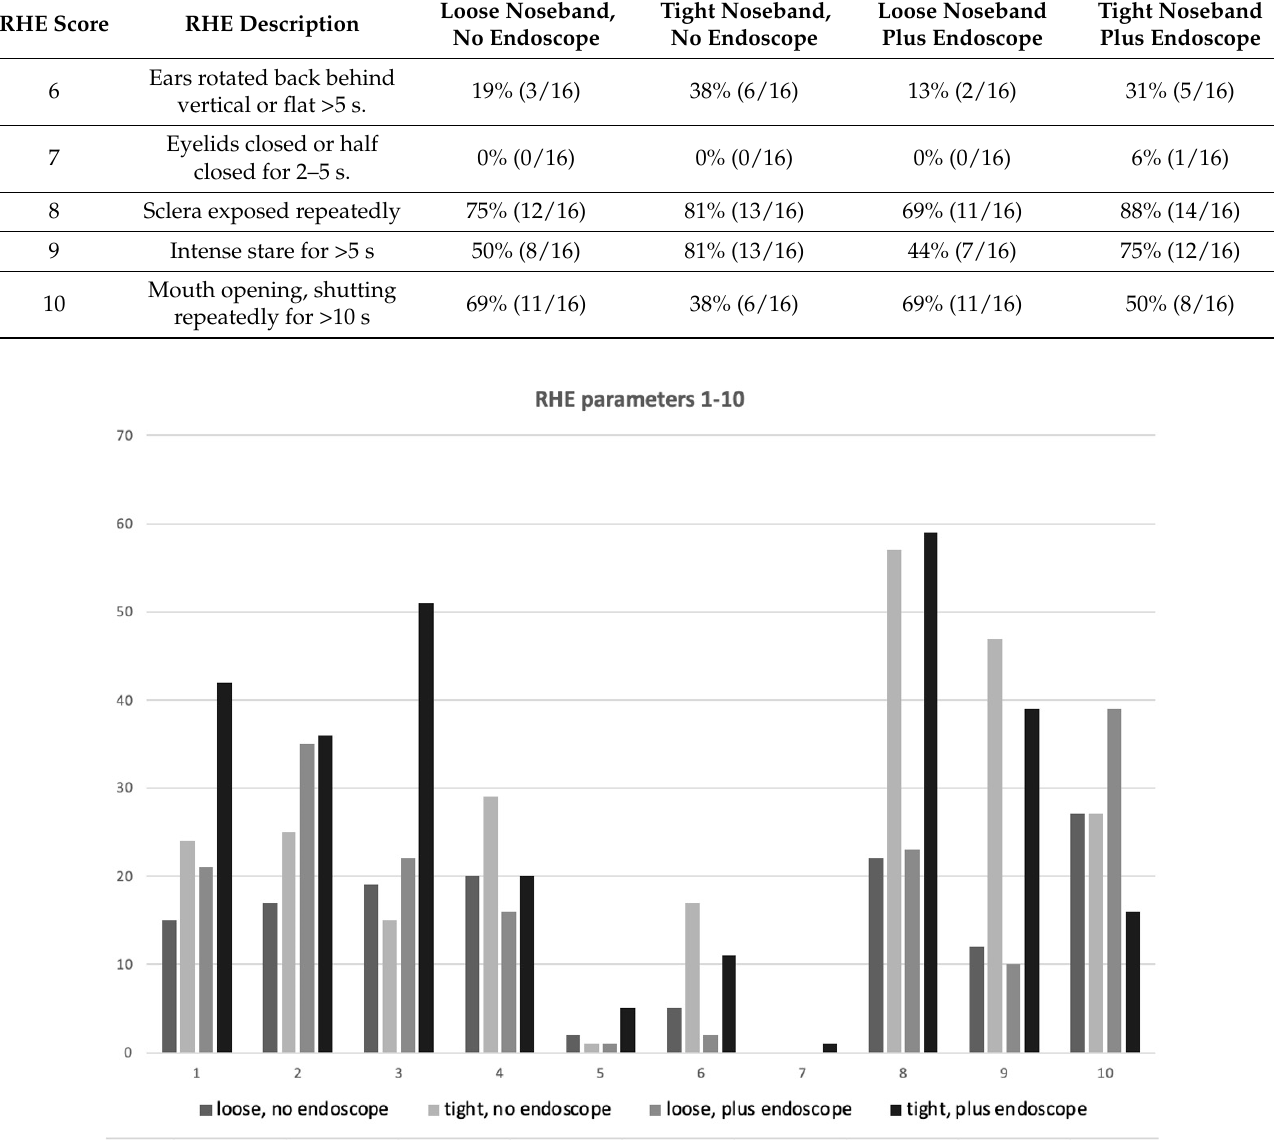
Figure 5. Frequency of individual RHE parameters 1–10 shown by the horses of each group (n = 16). The RHE scores correlated neither with the cortisol concentrations (level 1: p = 0.967, level 2: p = 0.419, level 3: p = 0.990, level 4: p = 0.268), nor with the SP levels (level 1: p = 0.929, level 2: p = 0.353, level 3: p = 0.456, level 4: p = 0.625). p = 0.929, level 2: p = 0.353, level 3: p = 0.456, level 4: p =